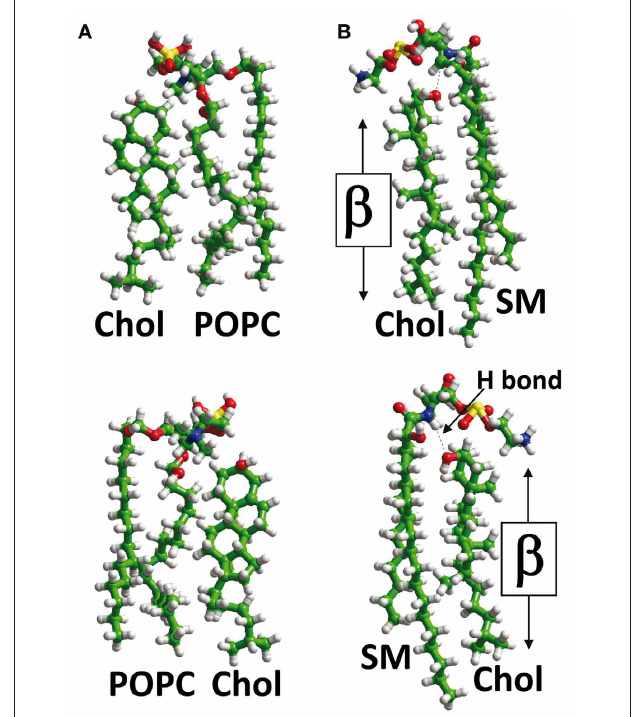
FIGURE 2 | Lipid-cholesterol interactions. In the plasma membrane, cholesterol (Chol) can interact with phosphatidylcholine, e.g., palmitoyl-oleyl-phosphatidylcholine (POPC) (panel A ) or sphingolipids such as sphingomyelin (panel B ). When cholesterol interacts with POPC, its OH group is not buried in the complex, and both its α and β faces are available for TM domains of proteins (A) . However, when cholesterol interacts with SM, a hydrogen bond (H bond) is formed between the OH group of cholesterol and the NH group of the sphingolipid. This H bond orientates cholesterol with respect to SM so that only its β face remains available for TM domains. The OH group of cholesterol is masked by the polar head of sphingomyelin in a typical “umbrella”